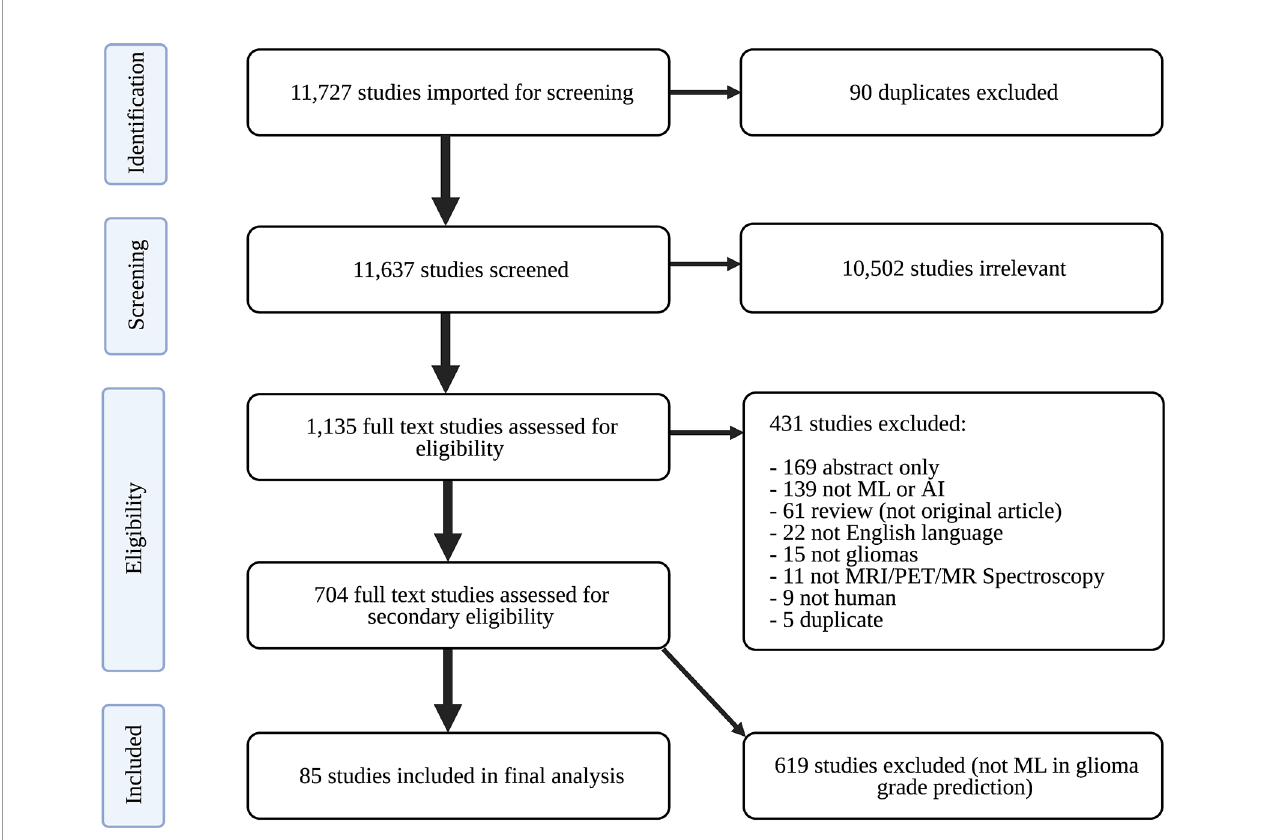
FIGURE 1 | PRISMA fl ow diagram of study search strategy. ML, machine learning; PRISMA, Preferred Reporting Guidelines for Systematic Reviews and